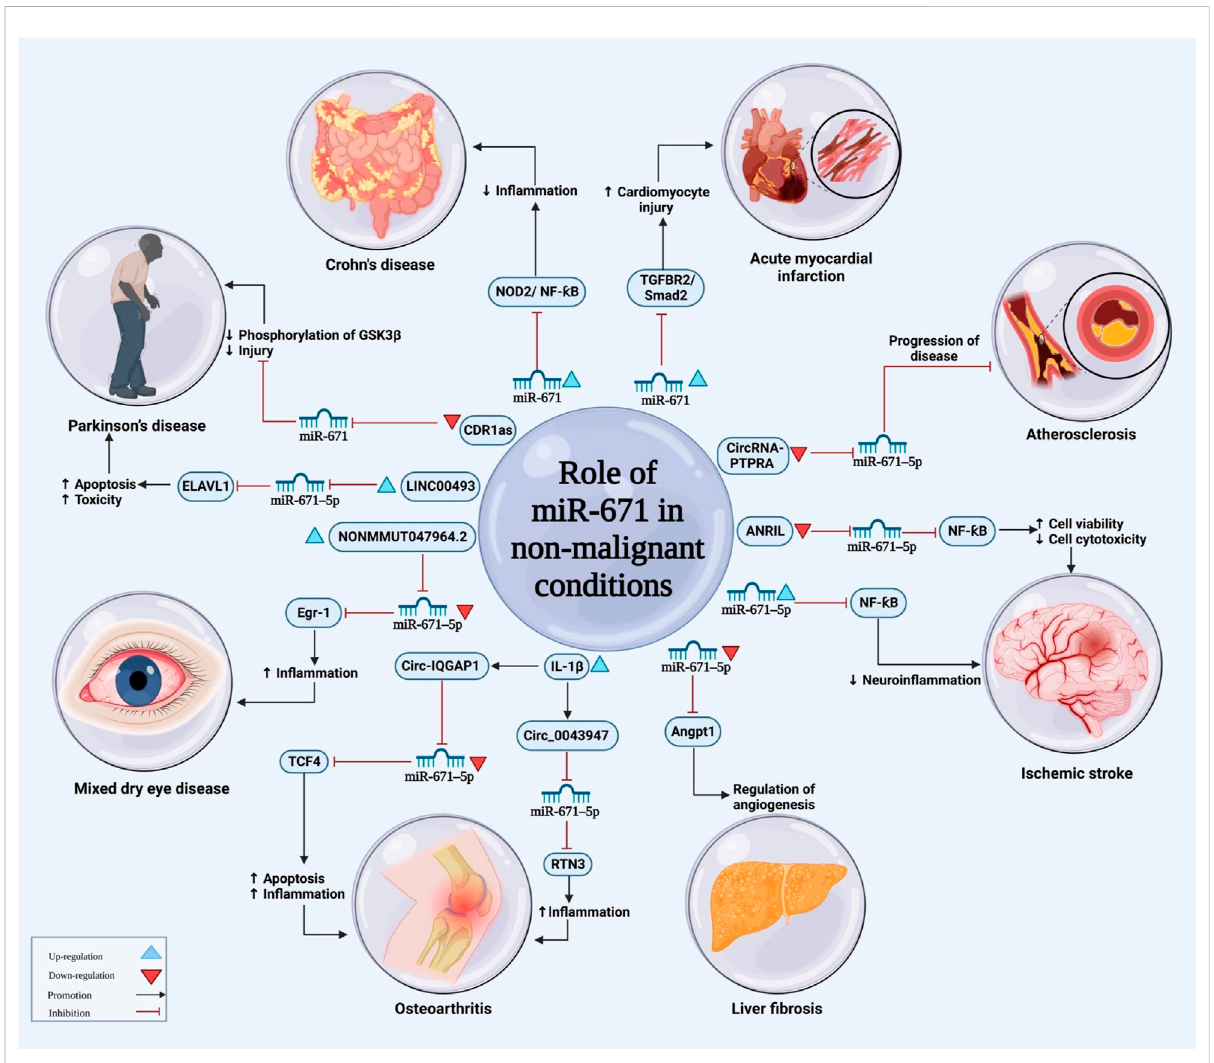
FIGURE 3 The illustration represents the main functions of miRNA-671 in non-malignant disorders. The level of miRNA-671 expression in fl uences the development of a wide range of disorders by modulation of several signaling